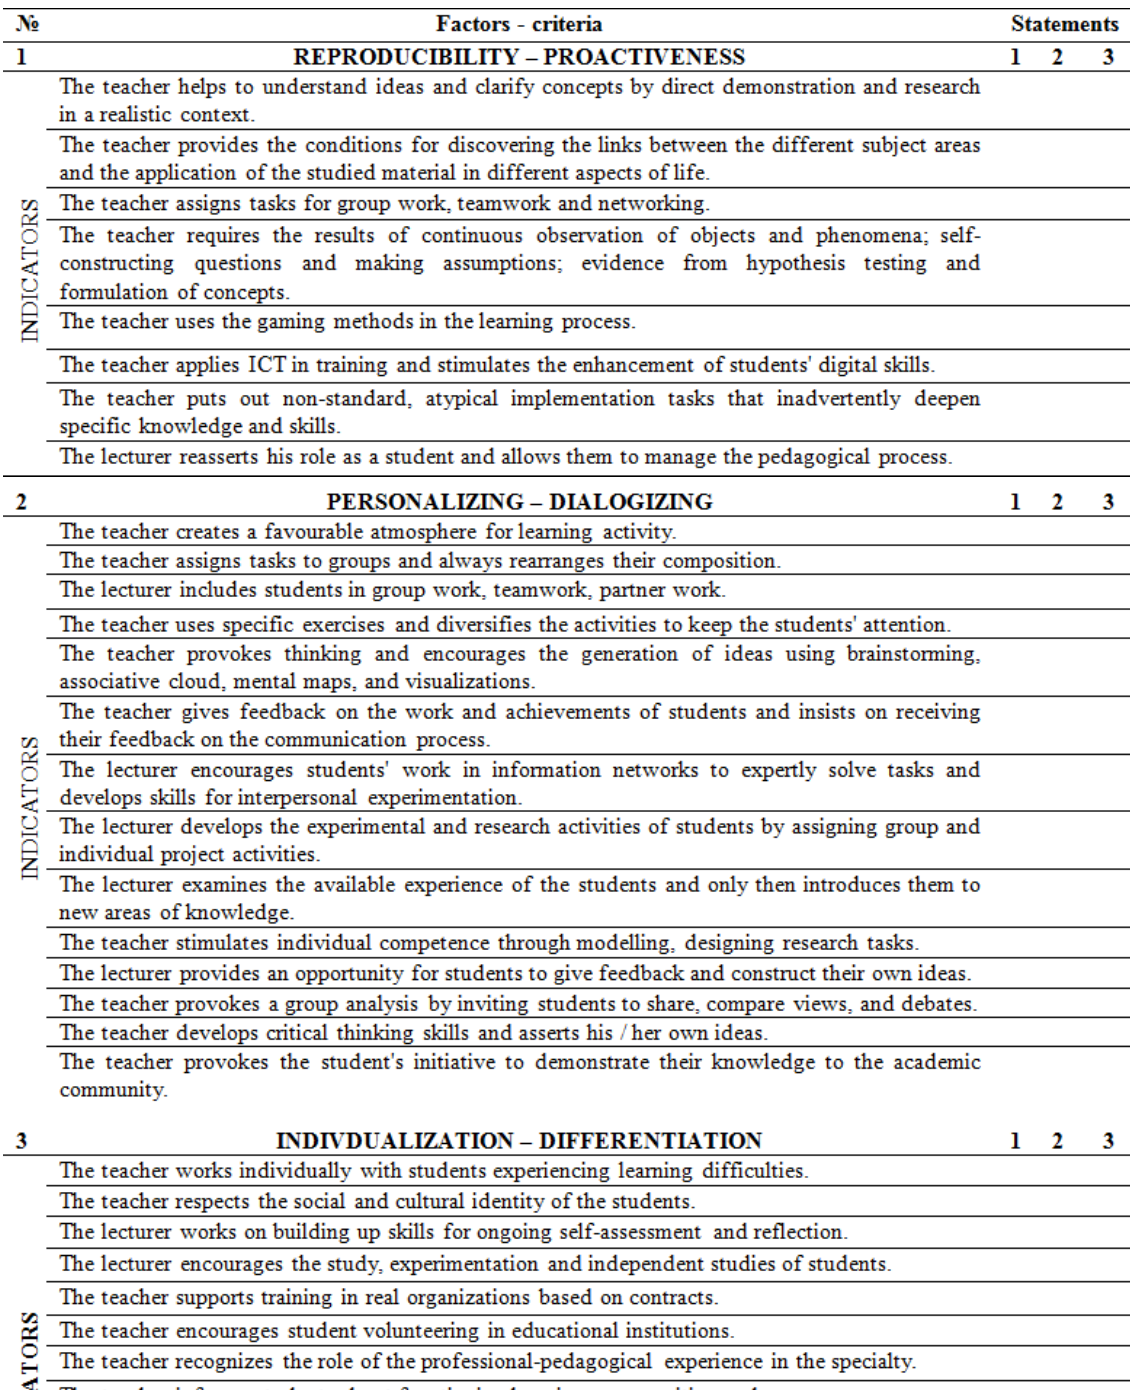
Table 3. Matrix for Students` self-assessment of the Learning